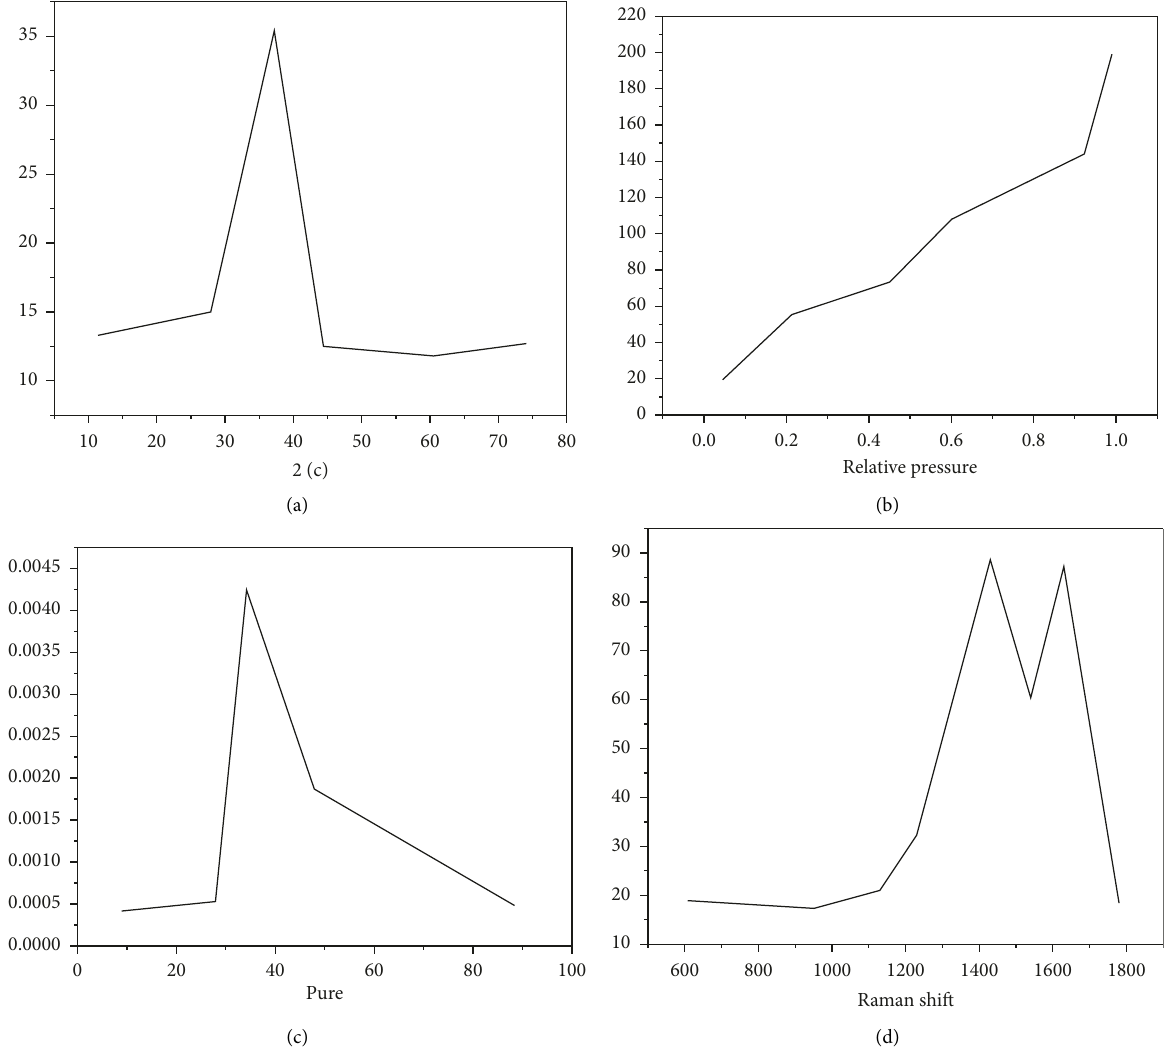
Figure 2: (a) XRD spectrum of molybdenum carbide/boron nitrogen codoped two-dimensional nanocarbon composite structure. (b) Isothermal nitrogen adsorption-desorption curve of molybdenum carbide/boron nitrogen codoped two-dimensional nanocarbon composite structure. (c) Pore size distribution curve of molybdenum carbide/boron nitrogen codoped two-dimensional nanocarbon composite structure. (d) Raman spectrum of molybdenum carbide/boron nitrogen codoped two-dimensional nanocarbon composite